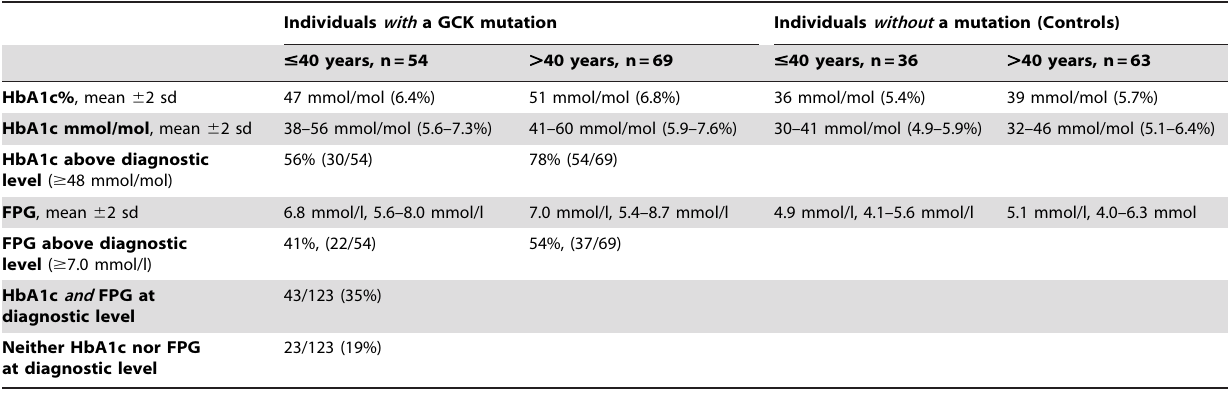
Individuals with a GCK mutation Individuals without a mutation (Controls)